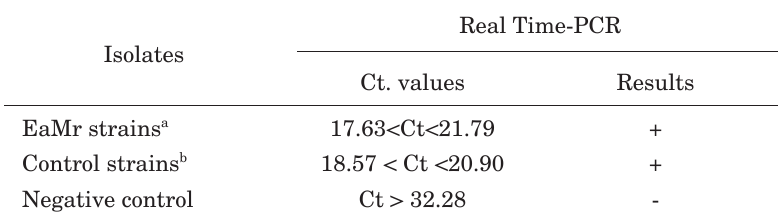
Table 4. Identi fi cation of the Erwinia amylovora Moroccan isolates by Real